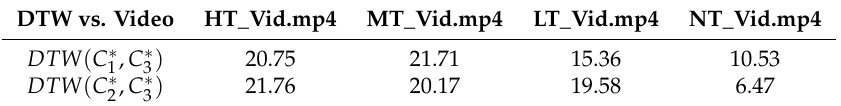
Table A3. Omnidirectional Traffic Curve Comparison: C ∗ Human Count (ground truth); the video frame size was 640 × 480, the interrogation window size was 90; and the interrogation window overlap was 60%.